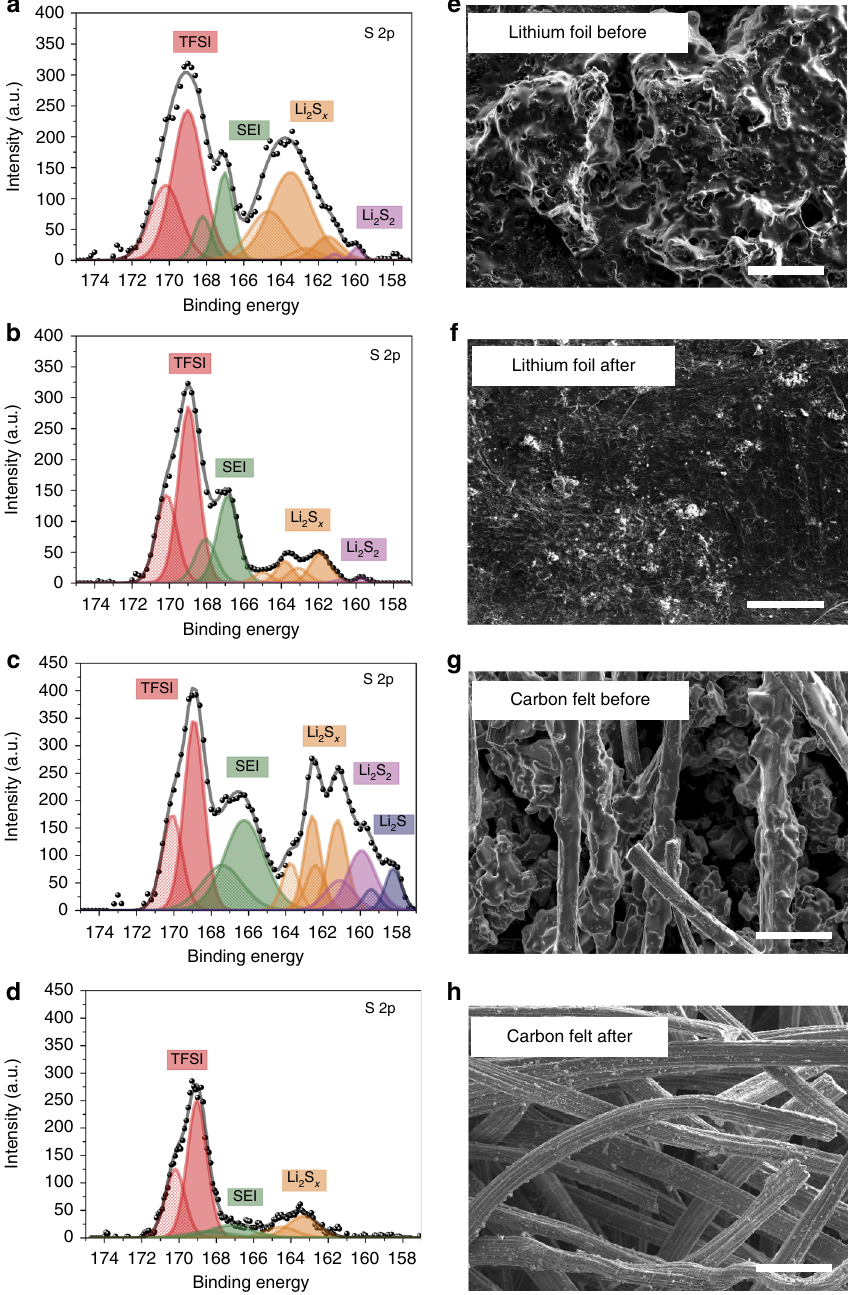
Fig. 3 Characterization of dead sul fi de species. a – d XPS analysis before and after reactivation: a , b lithium foil, c , d carbon felt. S 2p spectra are presented, including peak deconvolution and assignments. e – h SEM images before and after reactivation: e , f lithium foil ( scale bar , 100 μ m), g , h carbon felt ( scale bar , 50 μ